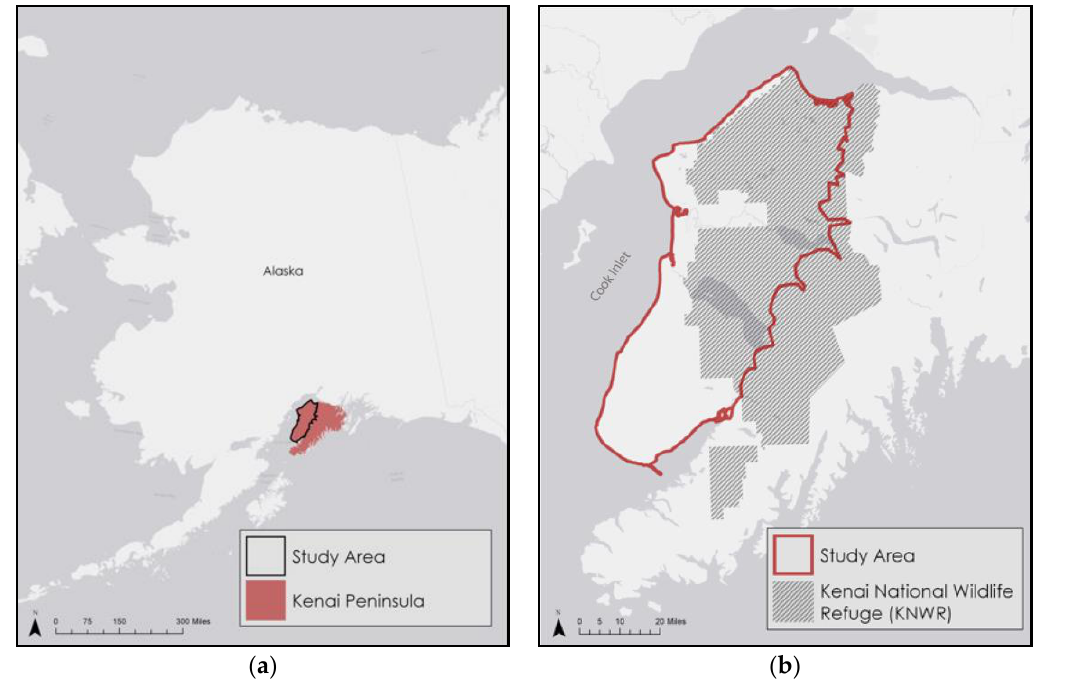
Figure 1. ( a ) Location of the study area and the Kenai Peninsula within Alaska; ( b ) Location of the study area and the Kenai National Wildlife Refuge within the peninsula.